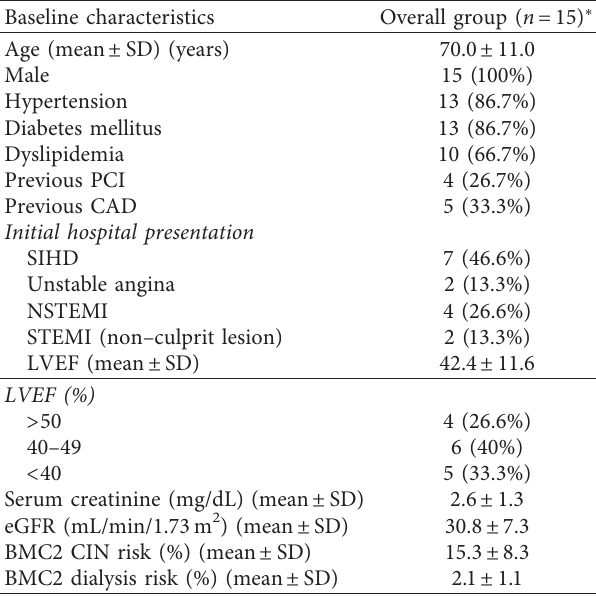
Table 1: Baseline clinical characteristics.